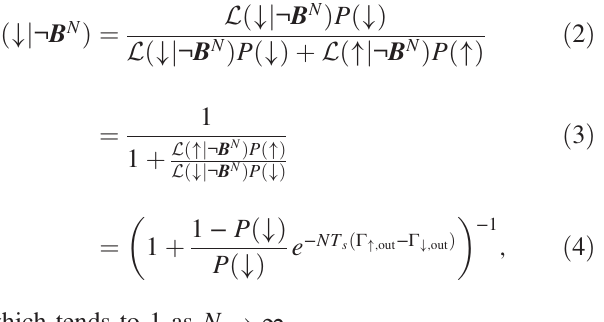
FIG. 2. (a) An example marginal likelihood function,